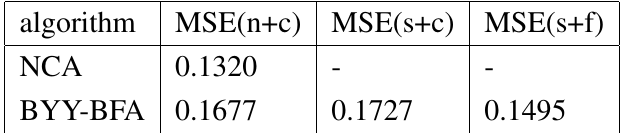
Table 2: Reconstruction mean square errors (MSE) of NCA and BYY-BFA on yeast cell-cycle data. We implement BYY-BFA(n) and BYY-BFA(s) in a combination of whether ( c ) constraining A with the connectivity topology from ChIP-chip assay or ( f ) using a free A